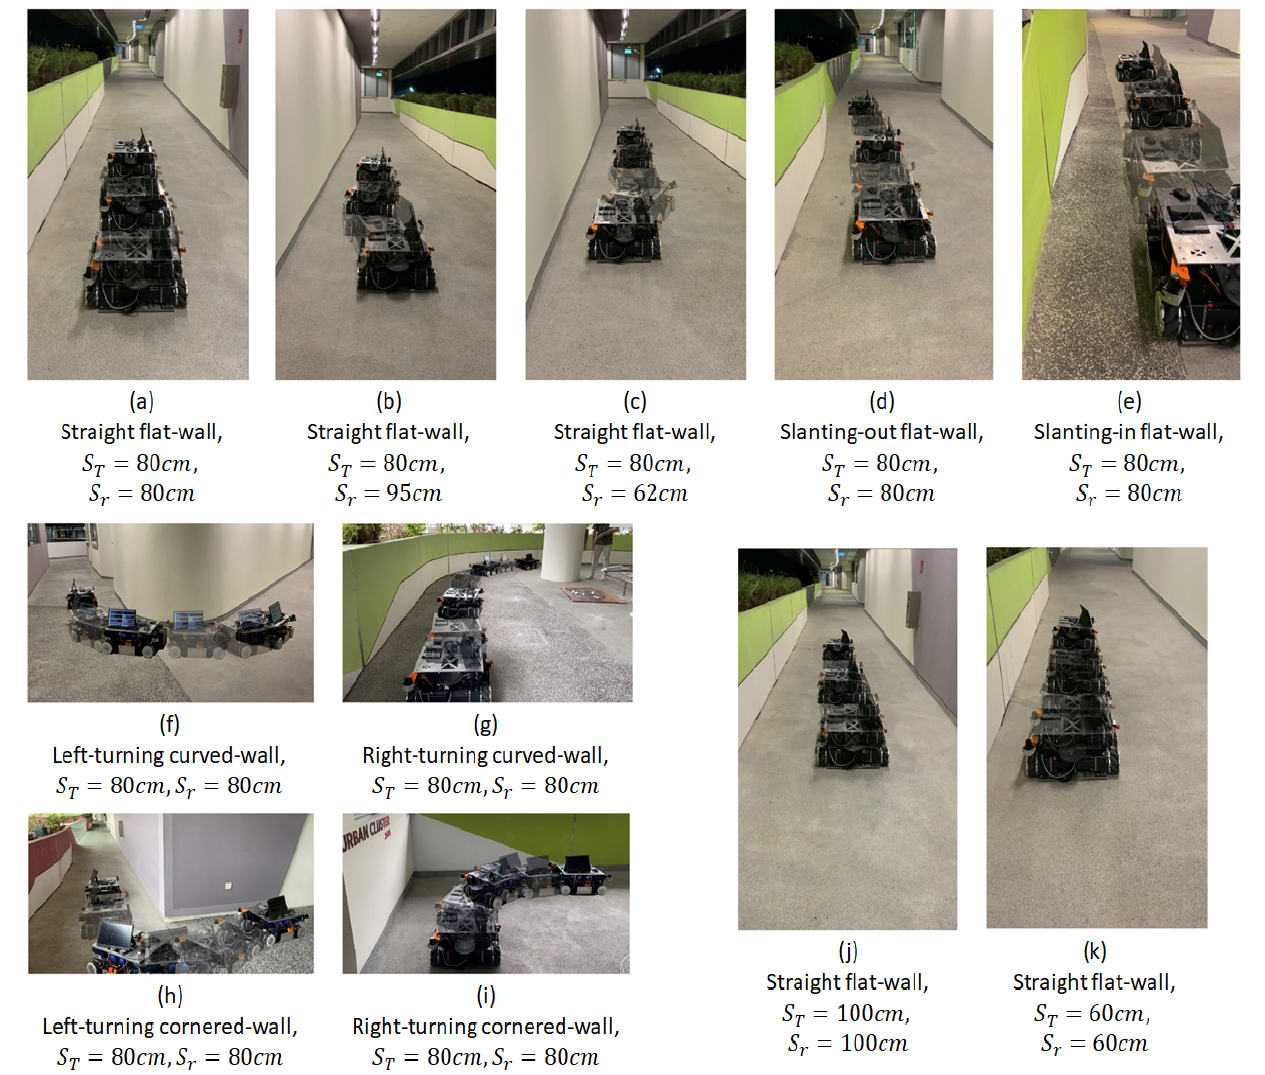
Figure 11. Robot motion trajectory in seven-frame time-lapse illustration. ( a – c ) show flat-wall experiments with different initial positions, ( d , e ) for slanting-wall experiments, ( f , g ) for curved-wall experiments, ( h , i ) for cornered-wall experiments, ( j , k ) for flat-wall experiments with different target side